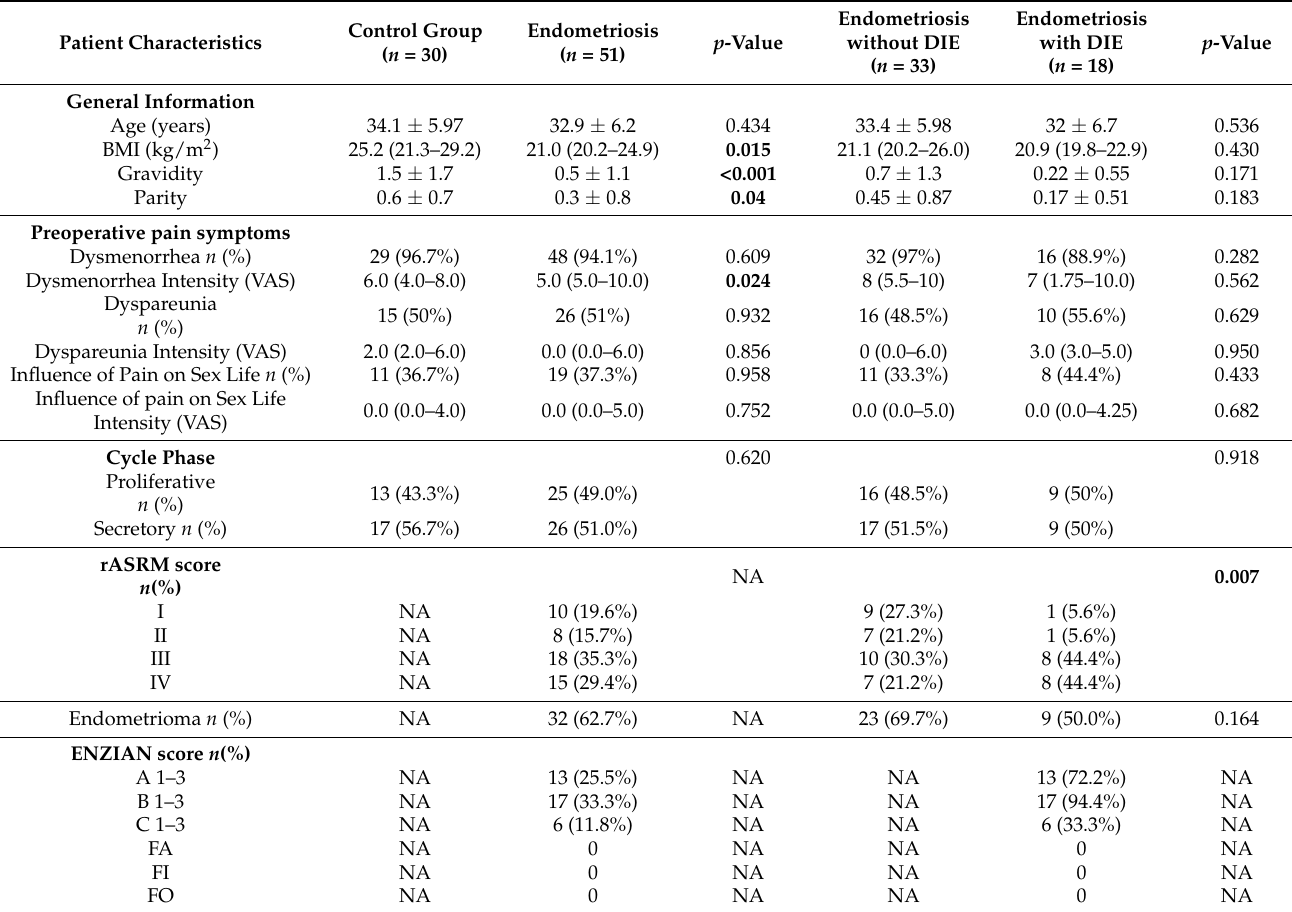
Table legend: the statistically significant values are set in bold. DIE: deep-infiltrating endometriosis, BMI: body mass index, VAS: visual analog scale, rASRM: revised American Society of Reproductive Medicine score, NA: not